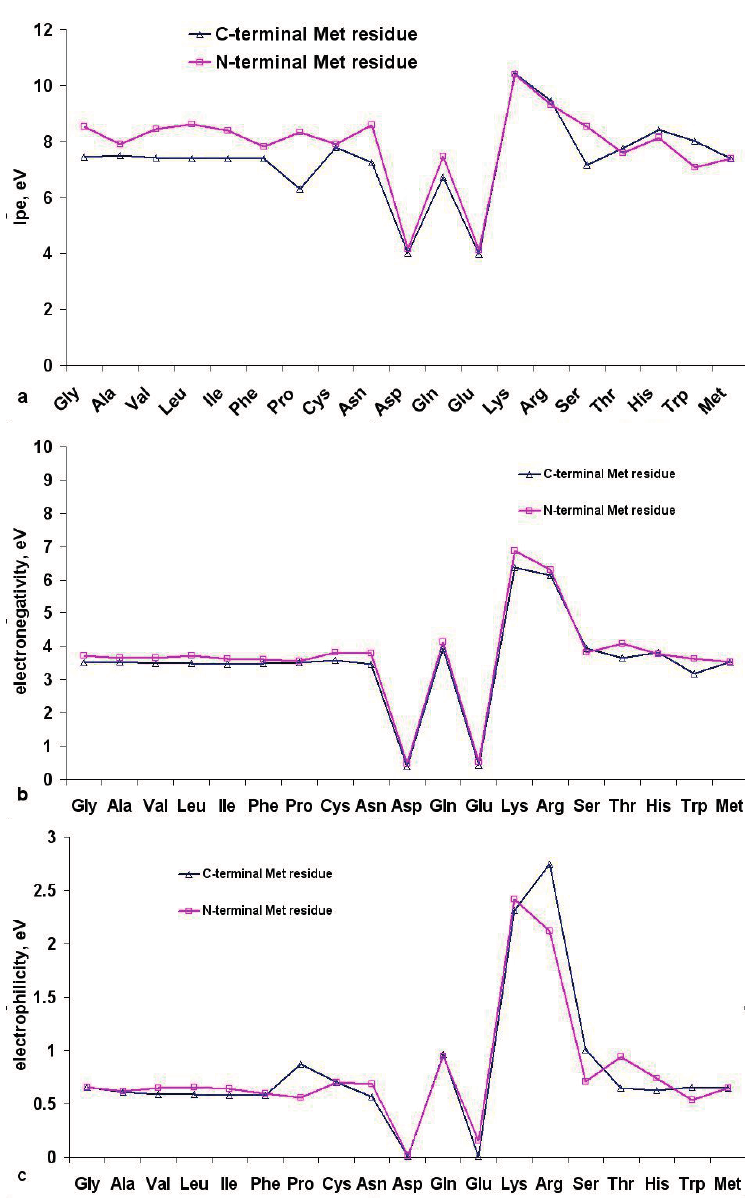
Figure 9. The ionization potential ( a ); electronegativity ( b ) and electrophilicity ( c ) of the dipeptides with N- and C-terminal position of methionine residues in the gas phase at 298